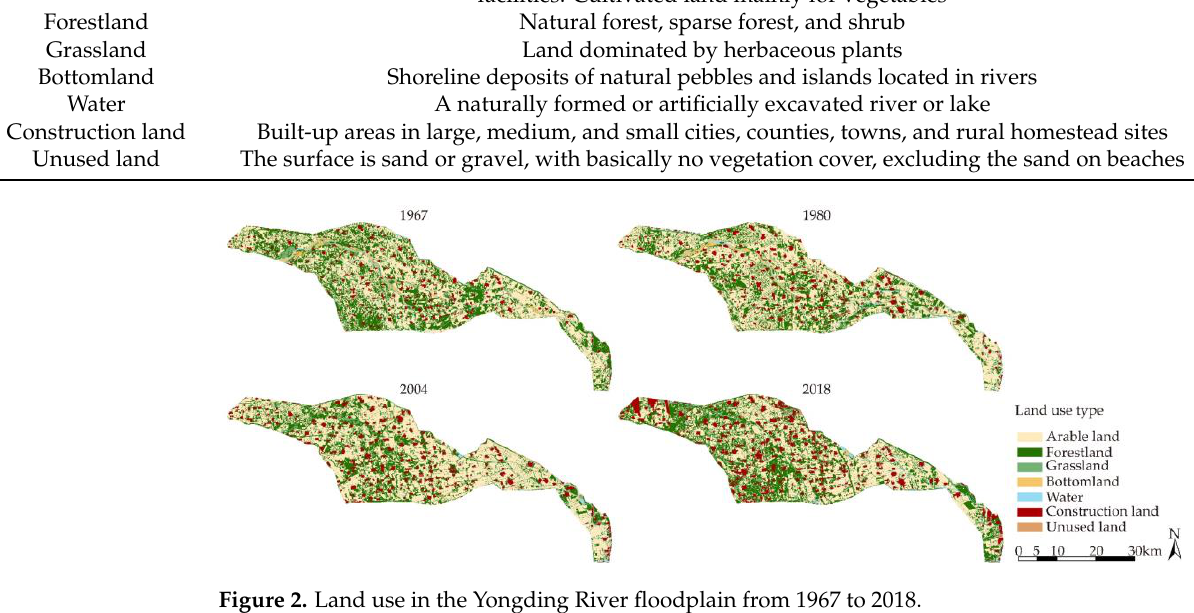
Table 3. Formulas for the landscape indices and their description.